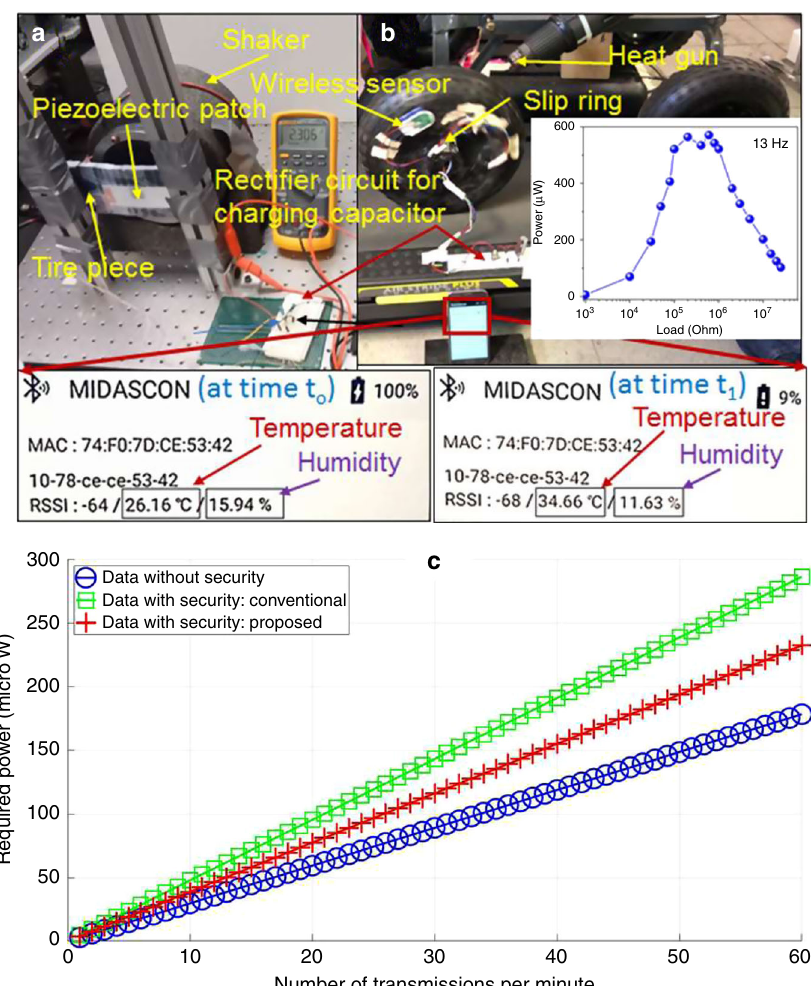
Fig. 8 Energy harvesting to power secure data transmission. a Photograph of the piezoelectric patch mounted on a piece of tire for energy generation. b Demonstration of the tire temperature and humidity sensing using a wireless sensor powered by the energy stored in a capacitor. This wireless sensor transferred information wirelessly to a mobile phone screen through a commercial app. The magni fi ed view of the mobile phone screen, at two different conditions, is shown in the bottom of b . The inset of b shows peak power versus load resistance plot obtained from the system shown in a . c Required power versus number of transmissions per minute with security, without security (conventional), and our proposed